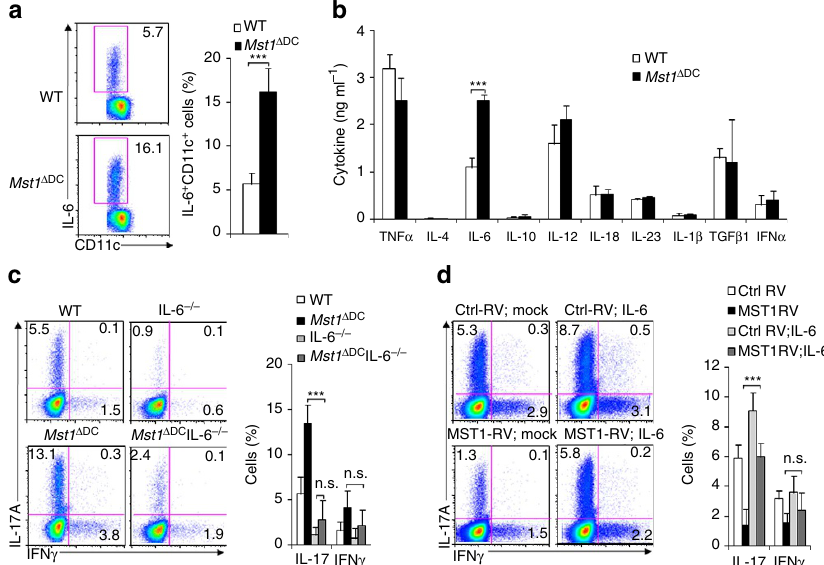
Figure 6 | MST1 controls DC IL-6 production during Th17 differentiation. ( a ) Intracellular staining of IL-6 in WT or Mst1 D DC splenic DCs 5 h after LPS stimulation in vitro . (Right) Proportion of IL-6 among the CD11c þ cells. The supernatant was collected and cytokine secretions determined with ELISA ( b ). ( c , d ) CD4 þ T cells from the indicated mice stimulated with WT or Mst1 D DC splenic DCs for 5 days. Intercellular staining of IL-17 and IFN g in T cells was determined with FCM and a typical figure is shown. Right, proportion of IL-17 and IFN g in T cells. Data are representative of three to four independent experiments (mean ± s.d.; n ¼ 4–5). *** P o 0.001, compared with the indicated groups. n.s., not significant. P -values were determined using Student’s t